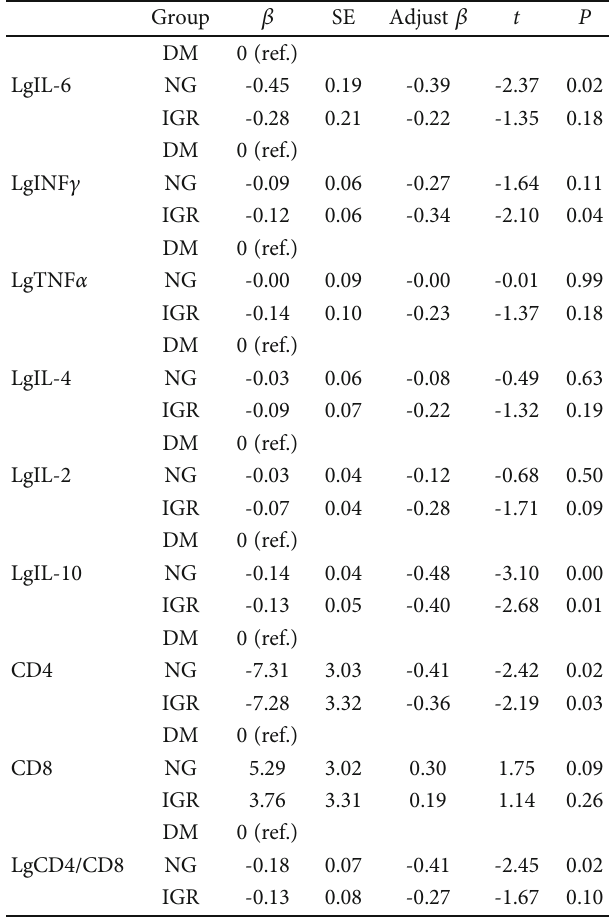
Table 4: Multiple linear regression analysis of T cell subsets and cytokines adjusted with